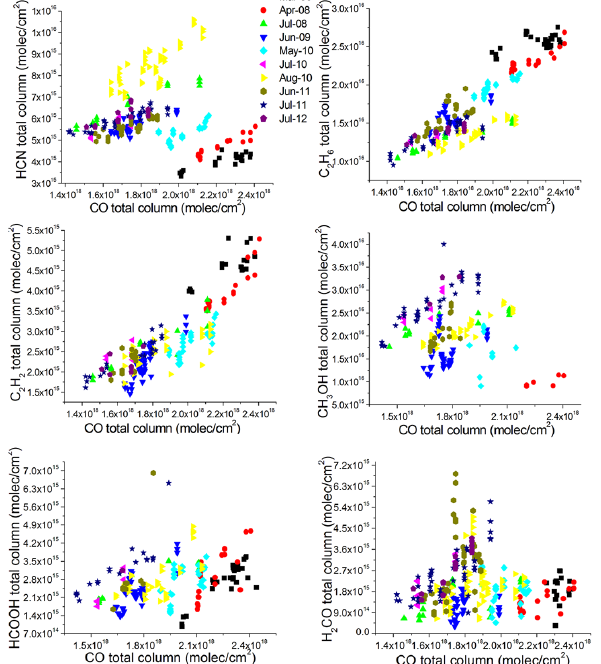
Figure 8. Scatterplots of the total columns of the target species (HCN, C 2 H 6 , C 2 H 2 , HCOOH, and H 2 CO) relative to CO for the eight fire events detected at Thule